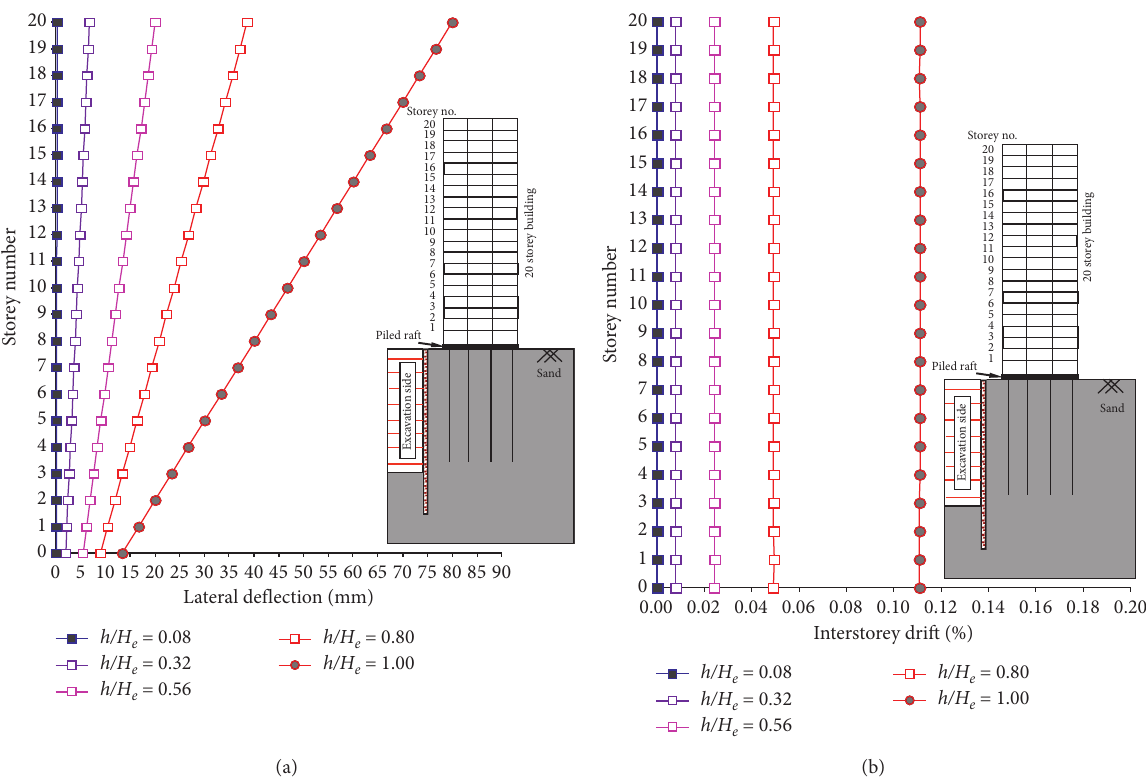
Figure 8: Lateral deflection and interstorey drift of the building on completion of excavation.